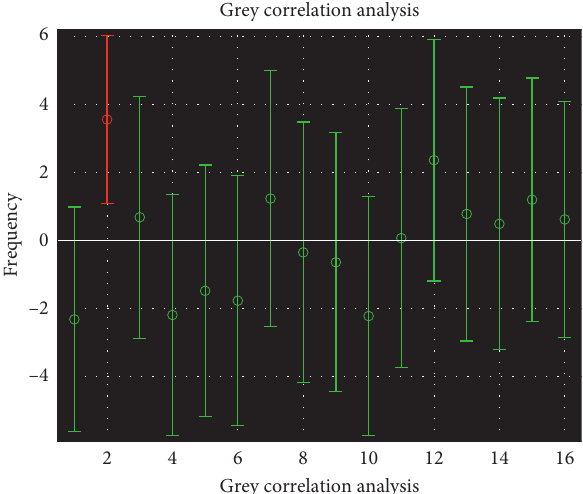
Figure 6: Histogram of regression standardized residual in grey relational